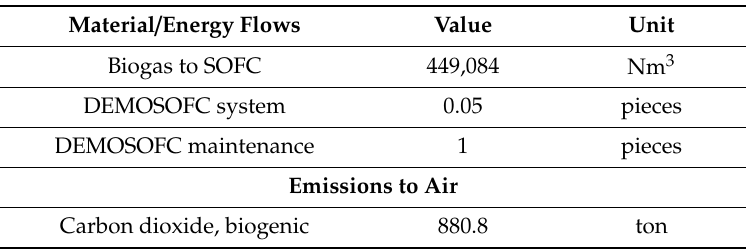
Table 8. The operational phase of the SOFC based CHP system. Reference flows, 1427 MWh electricity and 693 MWh heat (1 year of operation).